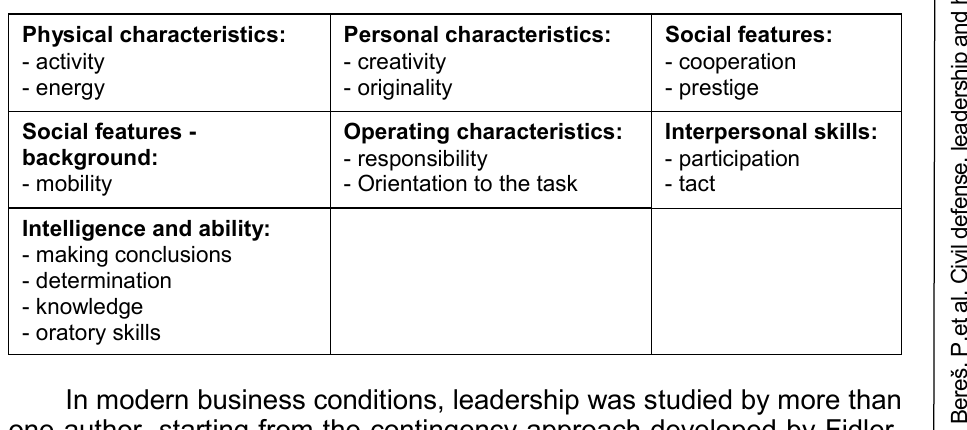
Table 2 – Some personal characteristics of leaders (Nikezi ć , 2011,